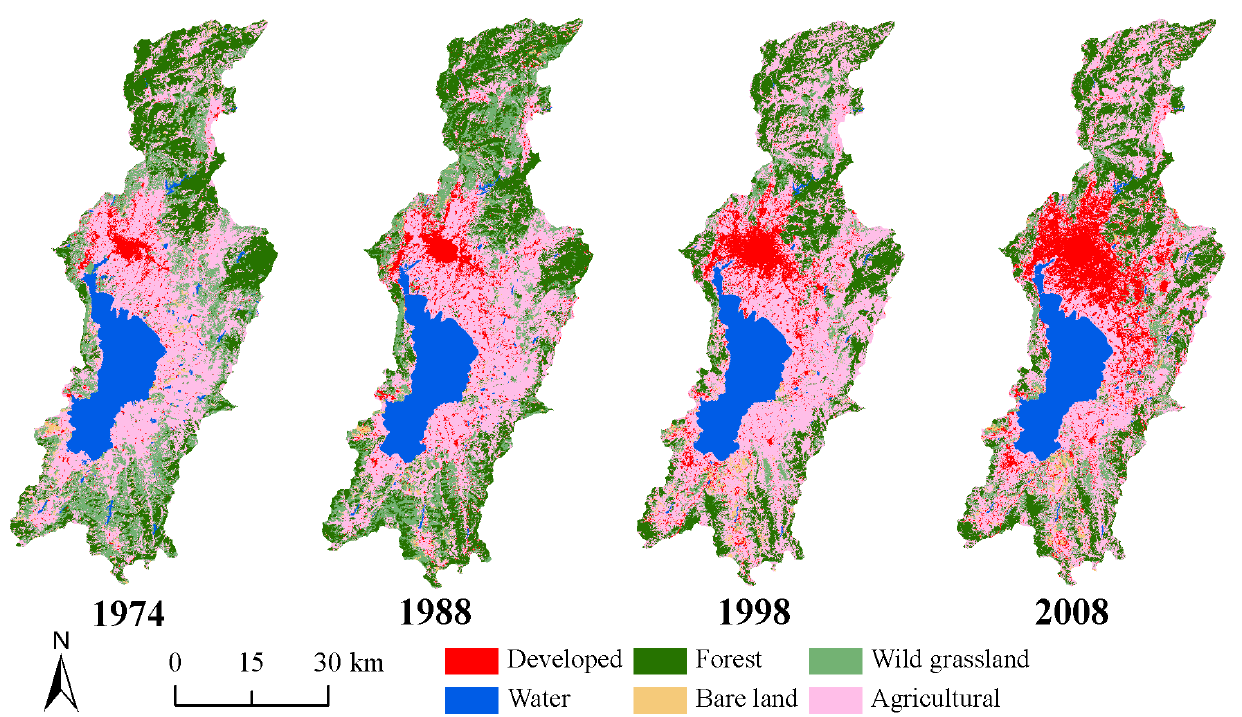
Figure 2. Land-use/Land-cover maps in 1974, 1988, 1998, and